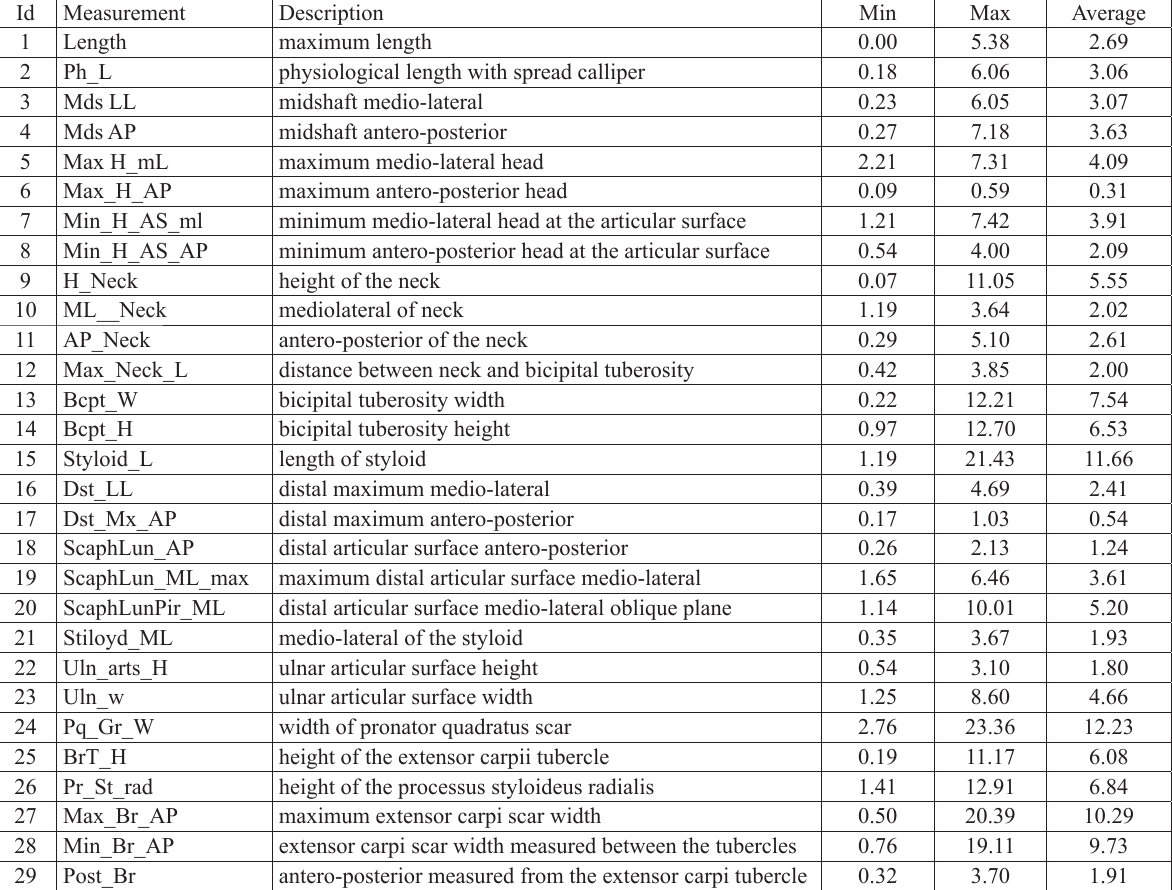
Table 1. Radial measurements (partitioned into proximal 3–14 and distal 15–29), showing minimum, maximum, and average error in percentage after three